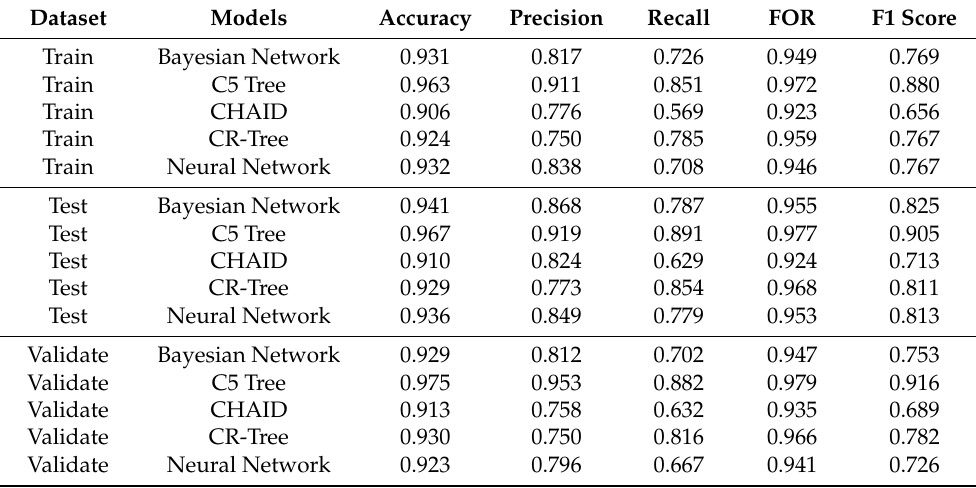
Table 3. Two-step clustering and k-nearest neighbors for the developed model.